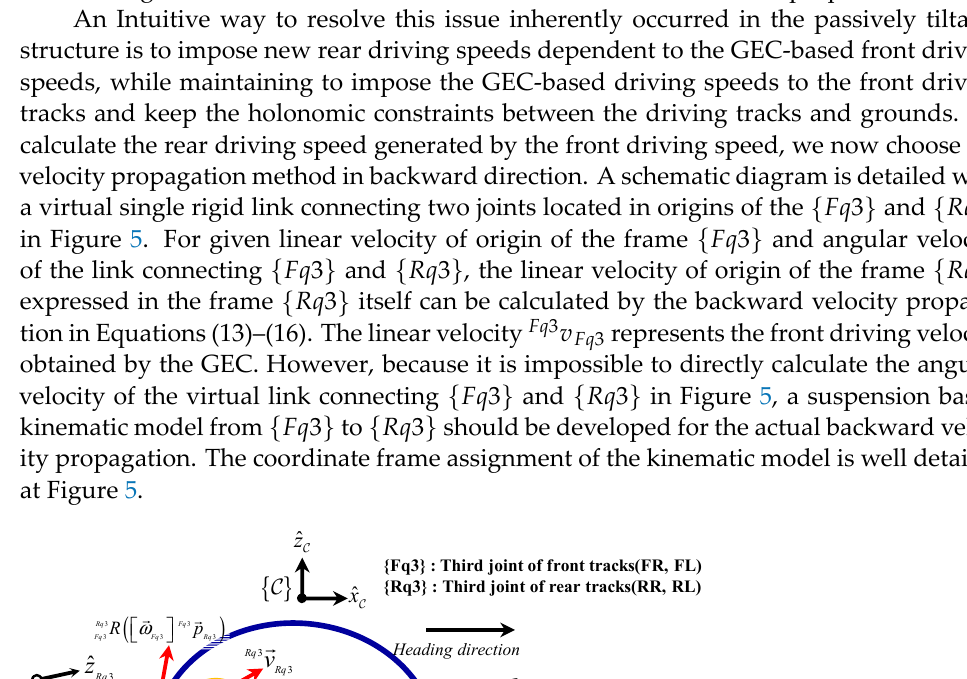
{Fq3} : Third joint of front tracks(FR, FL) {Rq3} : Third joint of rear tracks(RR, RL)